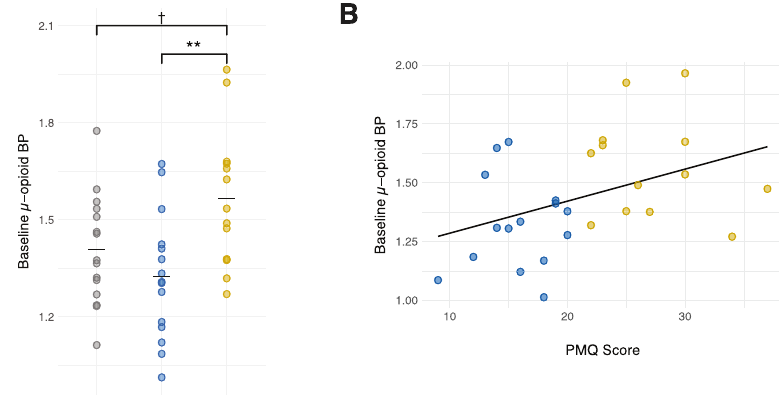
Fig. 2 Regional differences in Mu-opioid receptor binding between individuals at high and low opioid misuse risk. A Signi fi cant differences in baseline MOR BP ND between groups was obtained in the right amygdala, with individuals in the high-risk for opioid misuse group (PMQ-H) exhibited the highest mu-opioid receptor MOR BP ND . B Signi fi cant relationships between opioid misuse risk scores and baseline µ-opioid BP were also observed.